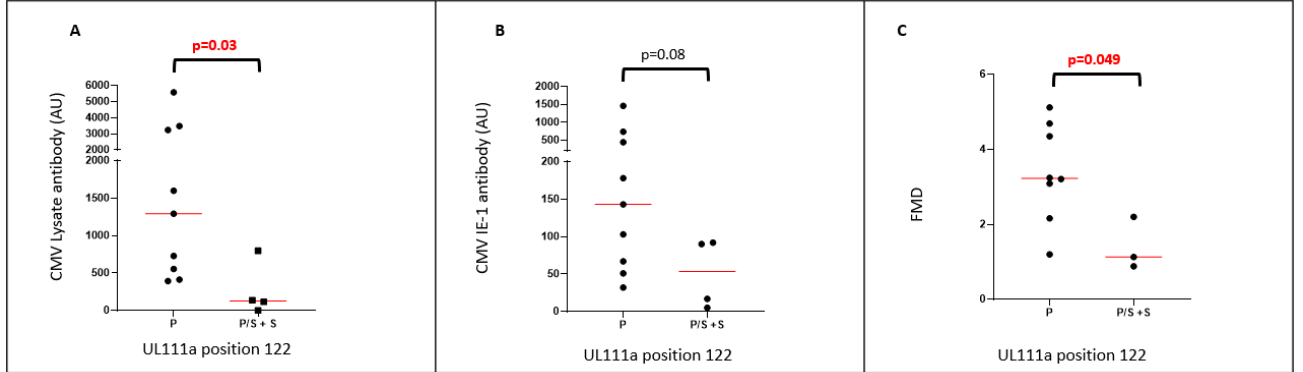
Figure 3. RTR carrying HCMV with the P122S variant have lower levels of HCMV-reactive an- tibodies and decreased FMD: ( A ) comparison of HCMV lysate-reactive antibodies in RTR carrying HCMV with P at position 122 and those carrying either P/S and S; ( B ) comparison of HCMV IE-1-reactive antibodies in RTR carrying HCMV with P at position 122 and those carrying either P/S and S; ( C ) comparison of FMD in RTR carrying HCMV with P at position 122 and those carrying either P/S and S.